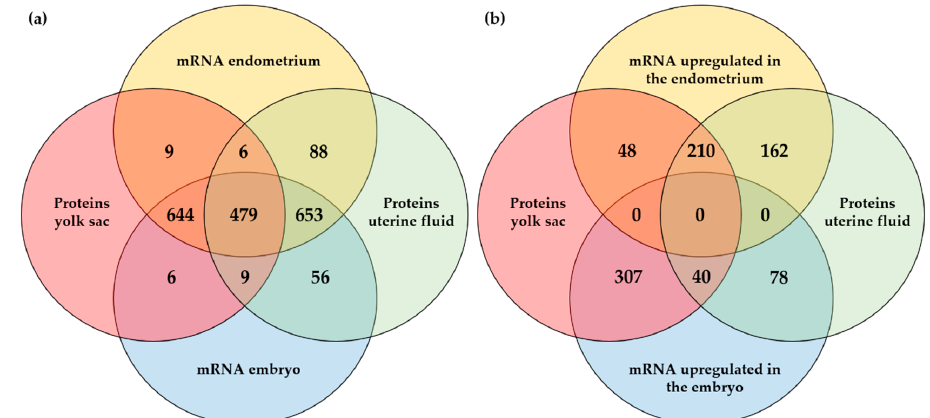
Figure 3. Comparison of proteins and mRNAs at the embryo–maternal interface on day 13 of pregnancy in the horse: ( a ) Comparison of mRNAs identified in the embryo and pregnant endometrium with the presence of the corresponding proteins in the uterine fluid (UF) and / or yolk sac (YS) fluid; ( b ) Comparison of differentially expressed mRNAs in the embryo vs. pregnant endometrium and the presence of the corresponding proteins in the UF and/or YS fluid.